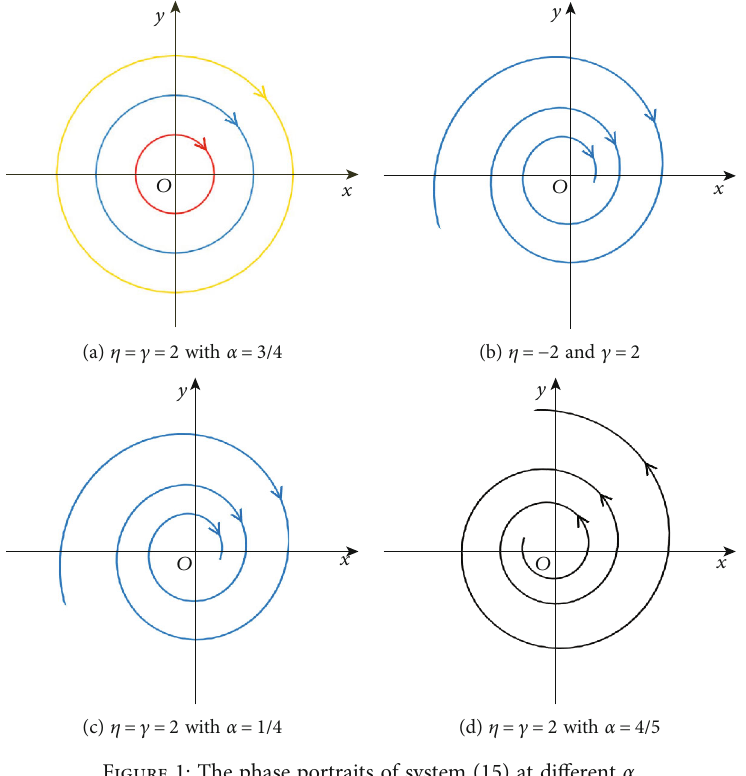
Figure 1: The phase portraits of system (15) at di ff erent α .